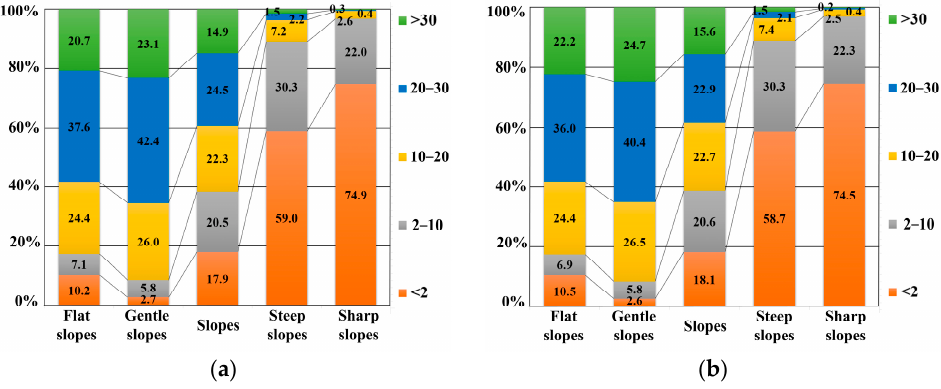
Figure 3. Percentage distribution of HAILS in different slopes: ( a ) 2015; ( b ) 2020.